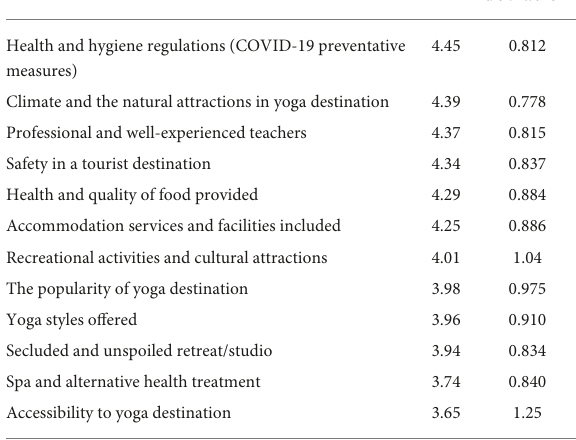
TABLE 4 Factors affecting the choice of yoga